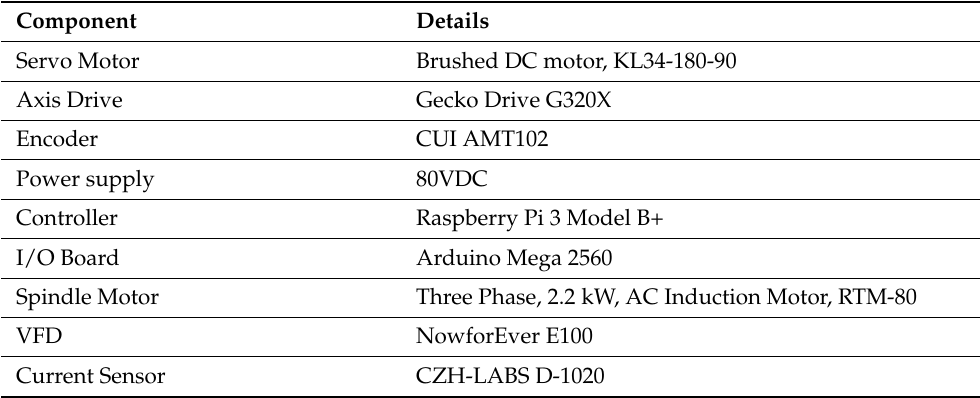
Table 2. Electrical